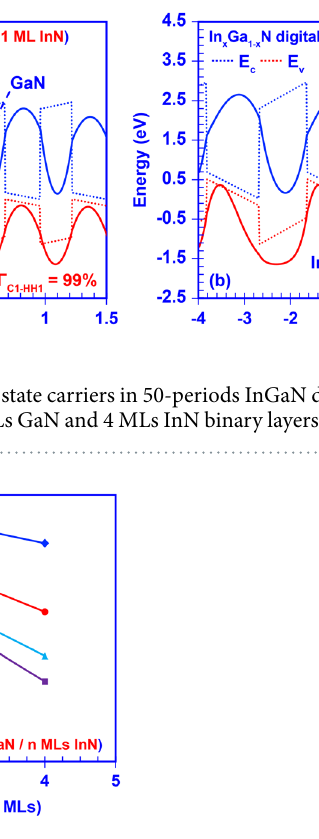
Figure 7. Ground state electron-hole wave function overlap as function of thickness of GaN binary layers (m MLs) and thickness of InN binary layers (n